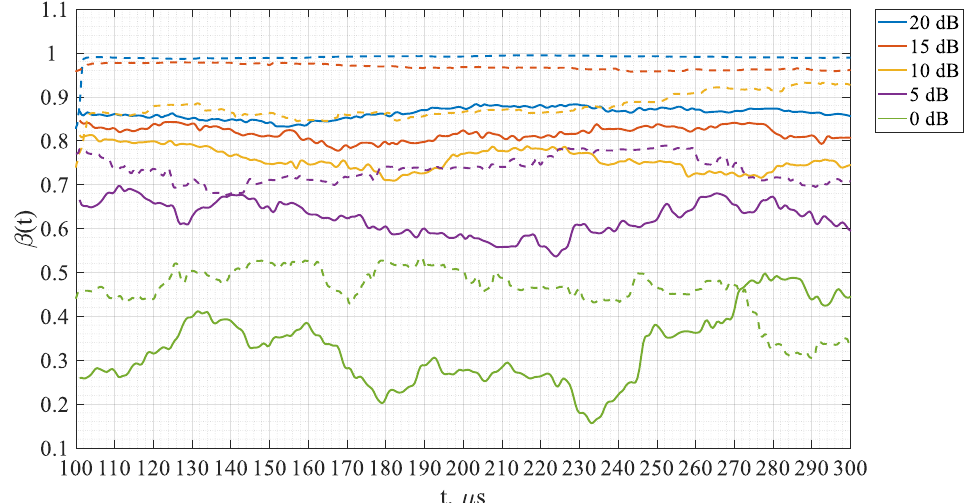
Figure 8. Hardware (solid lines) and simulation (dashed lines)-based results for the experimental